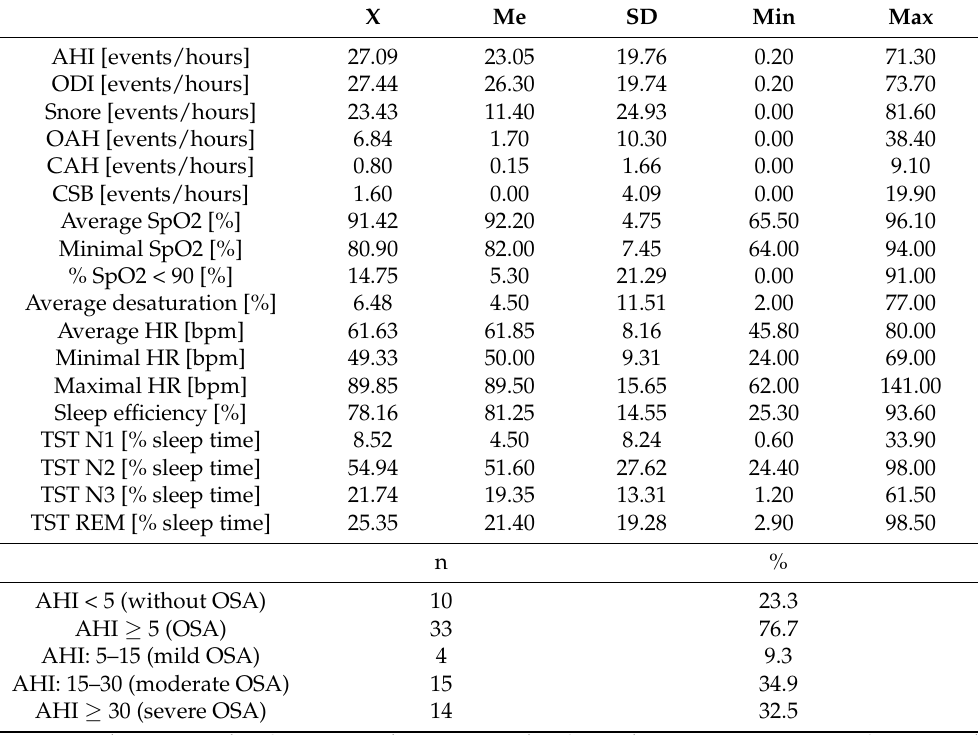
Table 2. Polysomnography parameters in the study group.